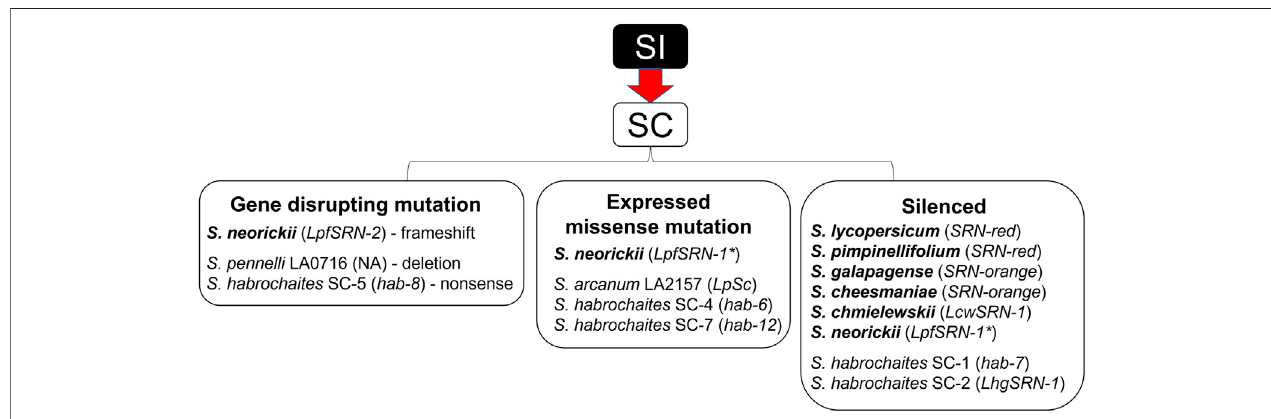
FIGURE 8 | Overview of S-RNase alleles associated with self-compatibility (SC) in the tomato clade. Species that are fully SC are shown in bold, for other predominately SI species, SC populations or population groups are listed. Names of S-RNase alleles are shown in parentheses. Missense mutations result in low S-RNase activity. * LpfSRN-1 is silenced in some accessions but is expressed and has low activity in others. For additional details see Table 1 and manuscript